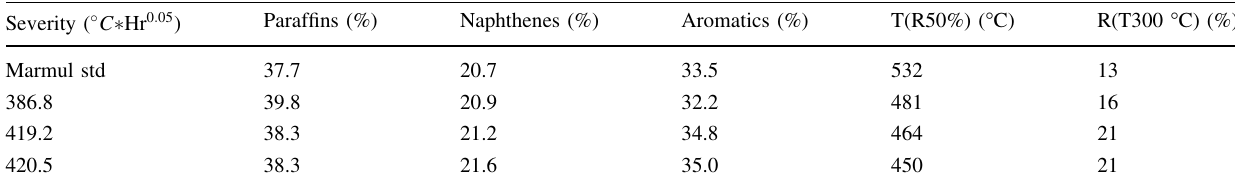
Table 1 Distribution of paraffins, naphthenes and aromatics, and the last two columns are the selected distillation points Severity ( (cid:3) C (cid:4) Hr 0 : 05